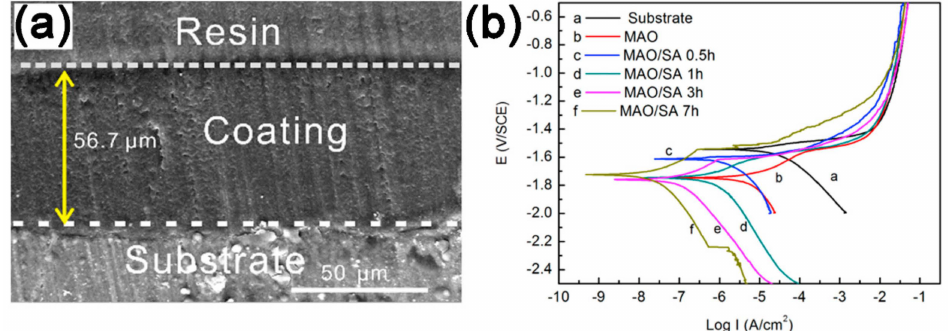
Figure 8. ( a ) Cross-view image of the MAO / SA 7h coating; ( b ) Polarization curves of the AZ31 substrate and the MAO coatings before and after modification with SA in 3.5 wt % NaCl solution. Reprinted from [76], Copyright (2017), with permission from